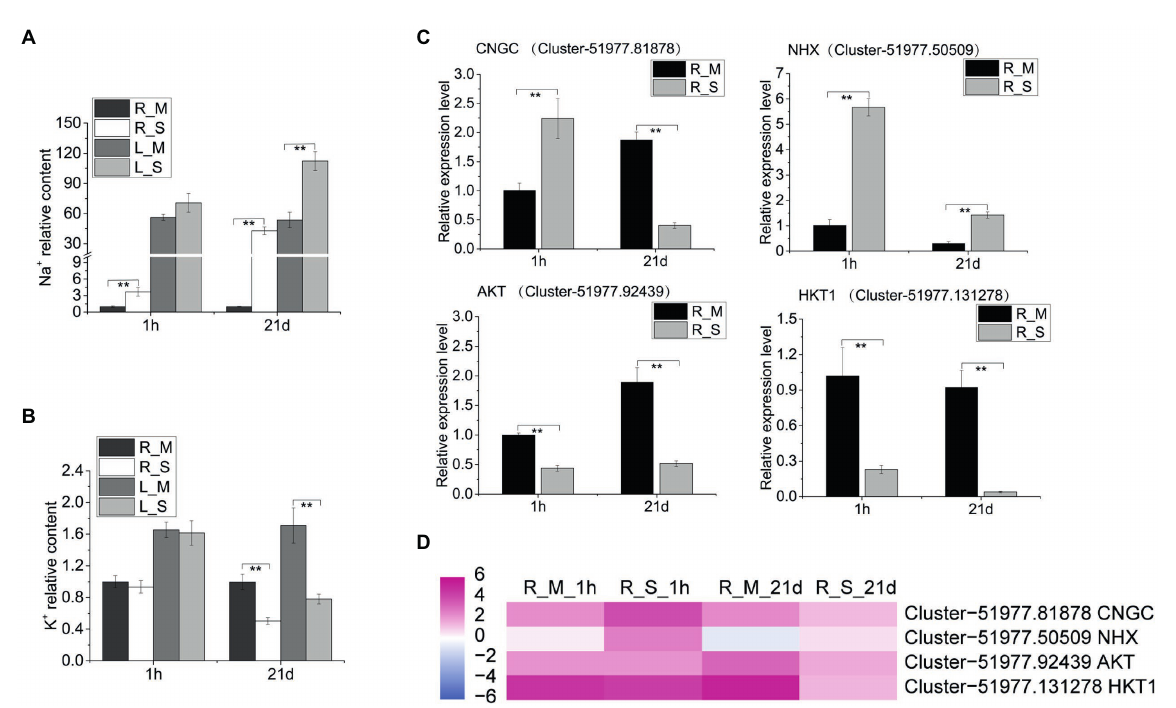
FIGURE 4 Tissue concentrations of Na and K and qRT-PCR analysis of relevant gene expression. (A,B) The relative content of Na and K in roots and leaves of plants after 1 h and 21 days of growth with 400 mM Na compared to the R_M sample. R_M and L_M mean roots and leaves of plants unexposed to Na. R_S and L_S mean roots and leaves of plants exposed to 400 mM Na. (C) qRT-PCR analysis of the expression of Na + and K + transport related genes. The error bars were calculated from three biological replicates. Mean differences were analyzed based on Tukey’s HSD test at p < 0.01 (**) levels. (D) The expression of genes (CNGC, NHX, AKT, and HKT1) in roots of plants treated with or without 400 mM Na. The data represent log 2 FPKM values based on RNA-Seq